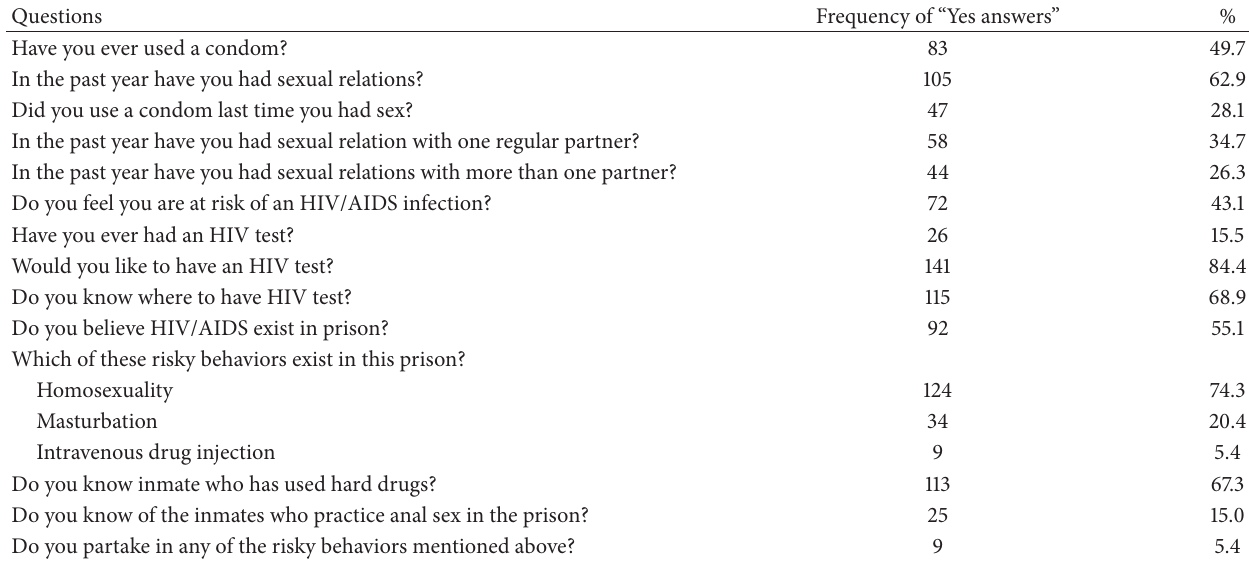
Table 4: HIV prevention practices by